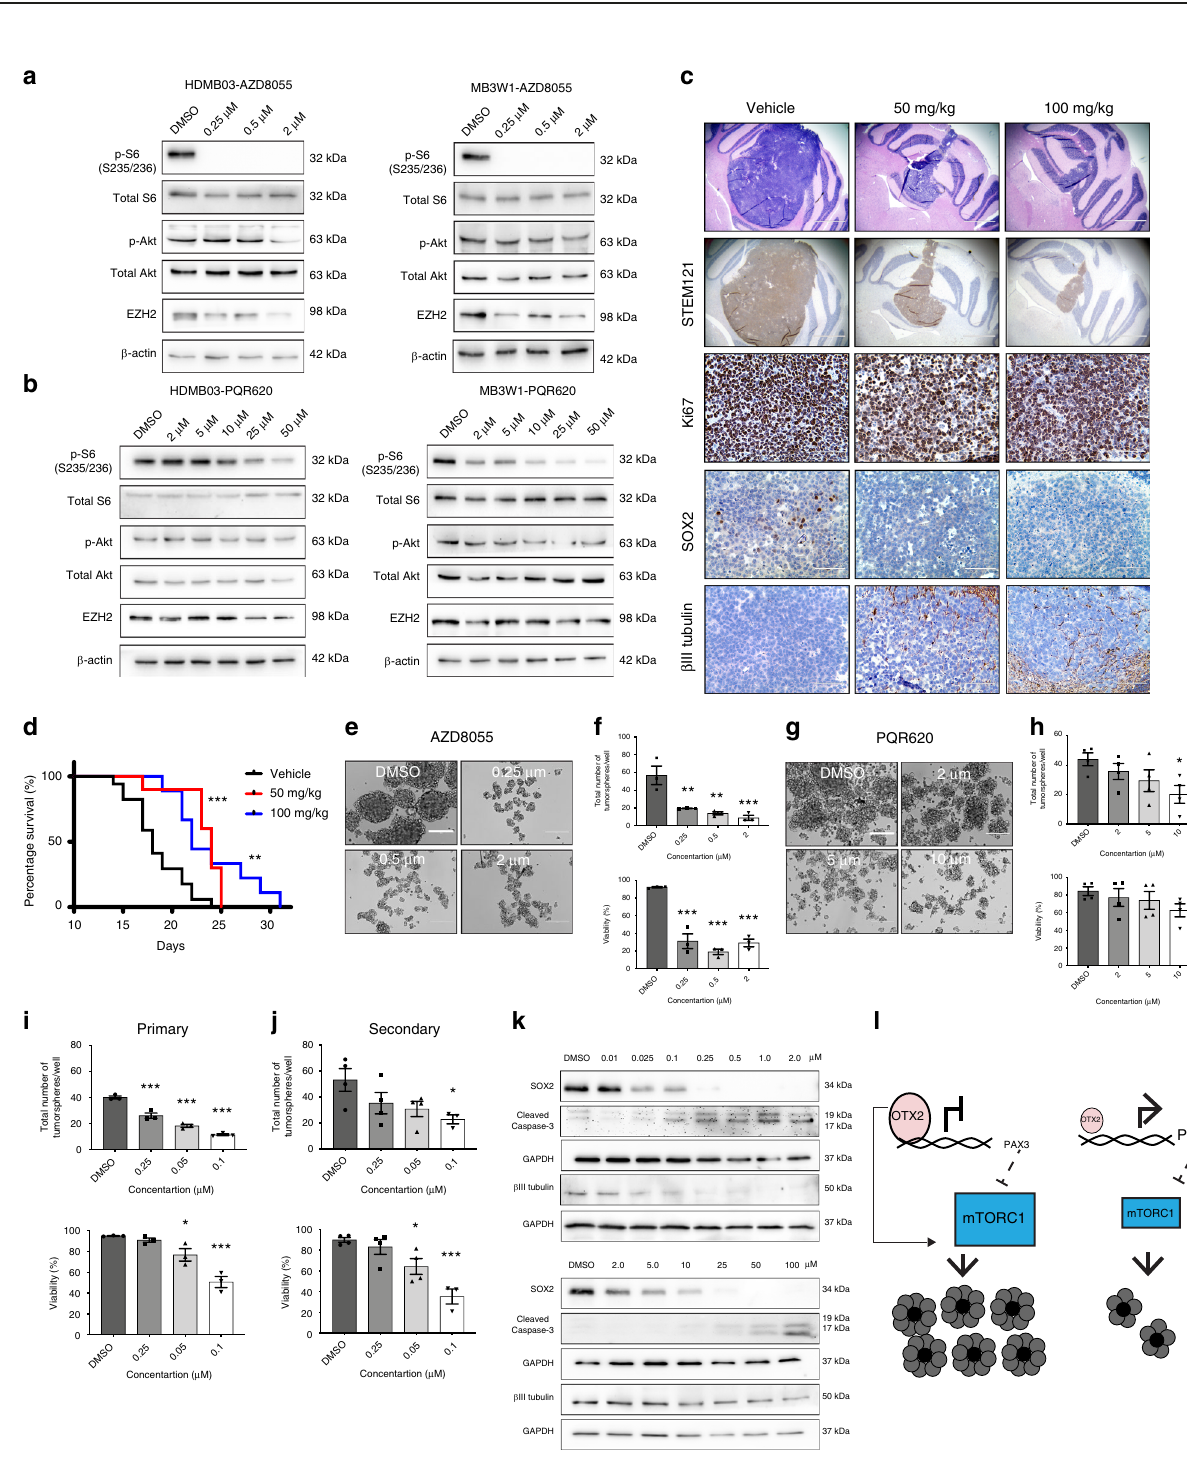
Fig. 7 Loss of OTX2 phenocopies PAX3 and PAX6 GOF in Group 3 MB cells. a – c EIF2 and mTORC1 signaling (highlighted) associated with genes that have signi fi cant changes in the H3K4me3 modi fi cation, following OTX2 silencing in Group 3 MB tumorspheres. Signi fi cance was calculated using a right- tailed Fisher ’ s exact test. d , e OTX2 silencing in HDMB03 ( d ) and D283 ( e ) tumorspheres with two independent siRNAs reduces SOX2, p-S6, p-4E-BP1, and Rheb levels. The neuronal differentiation markers DCX, β III tubulin, and EPHB2 are increased along with small increases in pRaptor in D283 tumorspheres only. Total S6, total 4E-BP1, total Raptor, GAPDH, and β -actin serve as loading controls. f Enriched biological processes and pathways determined using GSEA (Terms with FDR corrected q -value < 0.25) and visualized in Cytoscape v3.7.2 using Enrichmentmap. Each node in the map denotes a pathway, process or a transcription factor enrichment. The size of the nodes is proportional to the number of genes in the process. The nodes are connected when they share enriched genes. Nodes with asterisk denote the processes enriched with q < 0.05. g Representative images of p-S6 and p-4E- BP1 immunohistochemical staining in three independent FFPE Group 3 (upper) and Group 4 (lower) MB patient samples. Scale = 200 μ